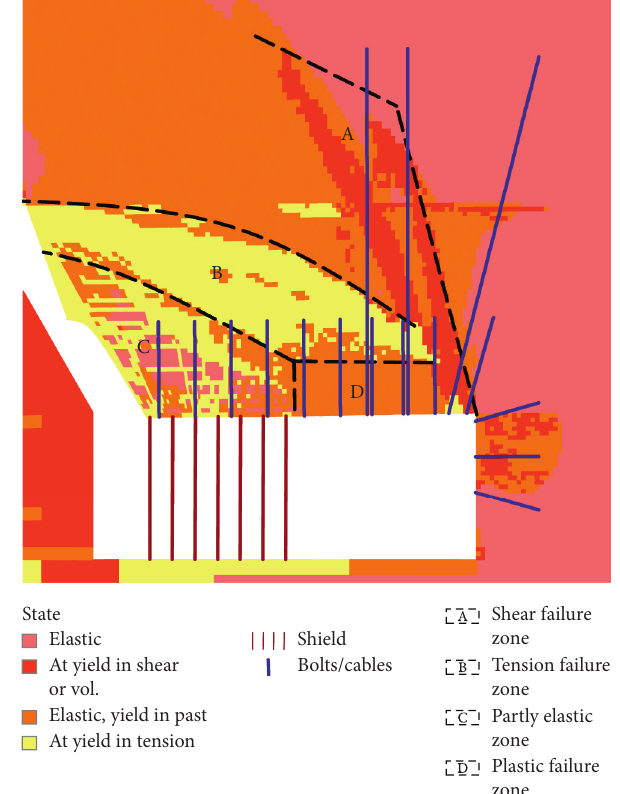
Figure 11: Distribution of failure zone around removal